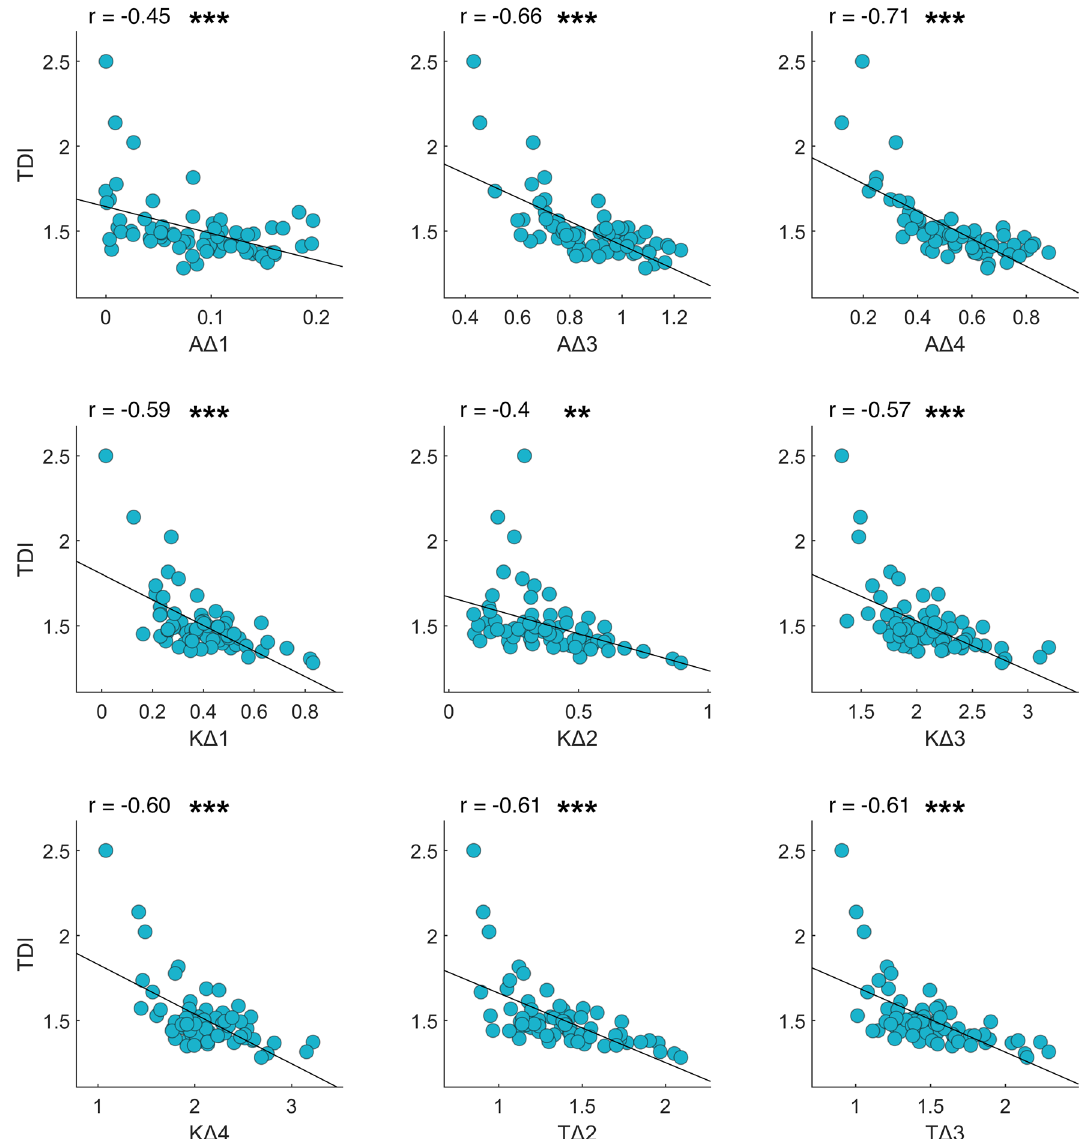
Figure 5. TDI and kinematic gait parameters. Pearson coefficient correlation between trunk displacement index (TDI) and kinematic gait parameters. The Δ values are calculated as the difference between two consecutive peaks (minimum or maximum joint excursion degree). The correlation includes healthy controls, individuals with Parkinson’s disease before L-DOPA intake, individuals with Parkinson’s disease after L-DOPA intake. Ankle Δ (AΔ−), Knee Δ (KΔ−), Thigh Δ (TΔ−). Significance p value: * p < 0.05, ** p < 0.01, *** p <